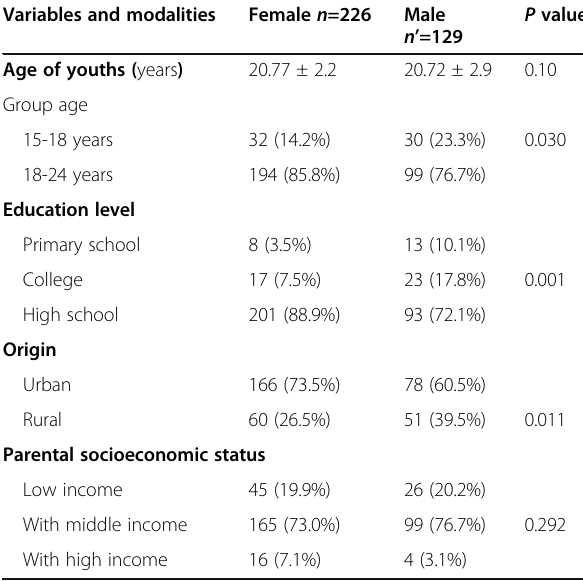
Table 1 Socio-economic and demographic characteristics of participants, distributed by gender Variables and